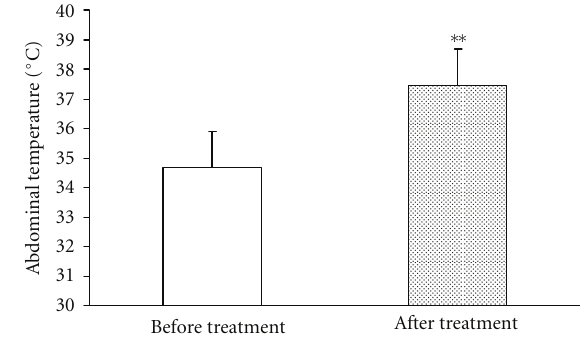
Figure 3: The average abdominal temperatures before and after treatment. Expression values are the mean and standard deviation, and the statistical di ff erence was analyzed by Wilcoxon signed-rank test. Double asterisk mean that this group was highly significantly di ff erent from control group ( P < 0 . 01).